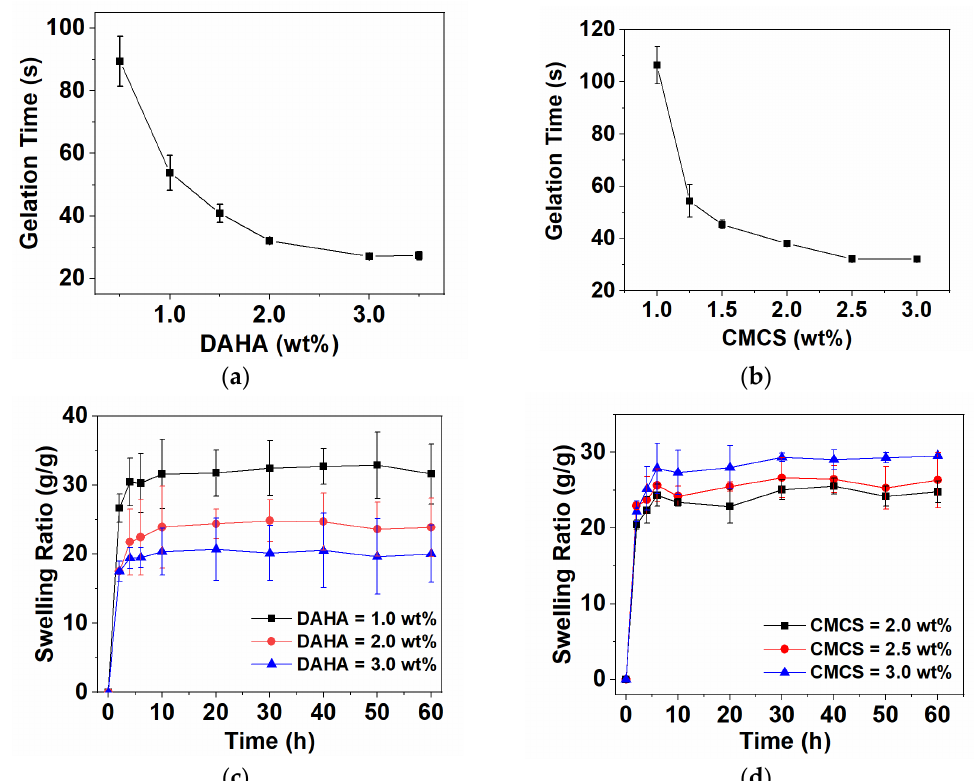
Figure 2. Effect of gelation time by DAHA and CMCS concentrations. [DAHA] = 0.5–3.5 wt%, [CMCS] = 2.5 wt% ( a ), [CMCS] = 1.0–3.0 wt%), [DAHA] = 3 wt% ( b ); Effect of swelling ratio by DAHA and CMCS concentrations. [DAHA] = 1.0–3.0 wt%, [CMCS] = 2.5 wt% ( c ), [CMCS] = 2.0–3.0 wt%, and [DAHA] = 3 wt% ( d ).